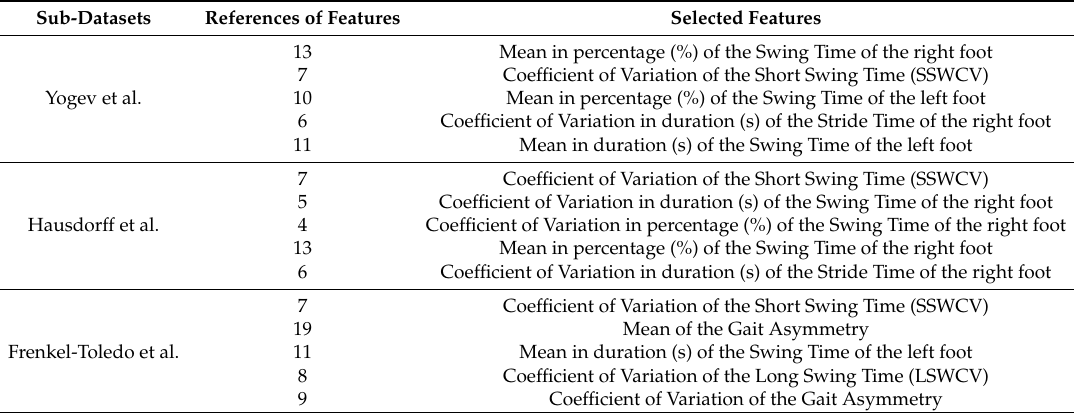
Table 4. The five most relevant features from each sub-dataset obtained using the RF feature selection